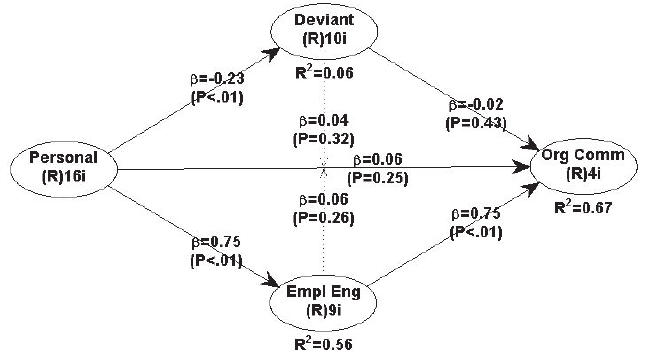
Fig. 1. Structural Model based on